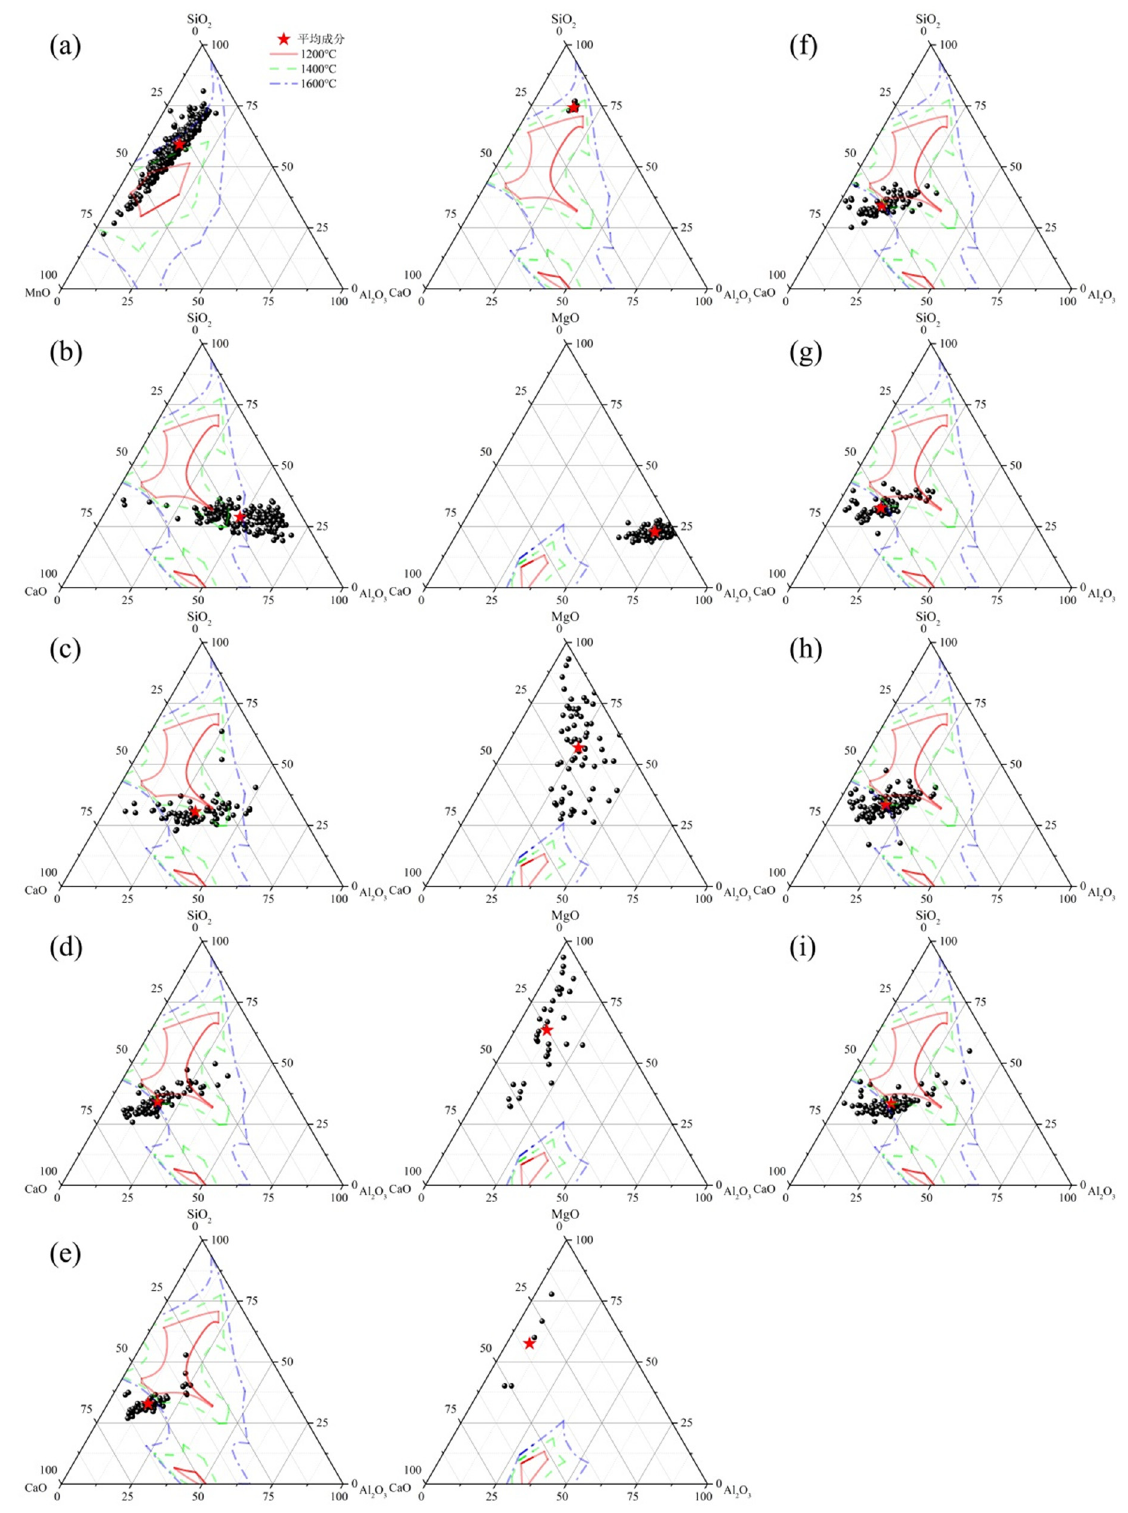
Figure 4: Composition distribution of inclusions at di ff erent stages during the LF – RH re fi ning process in heavy rail steel: ( a ) LF start; ( b ) after fi rst - time electrode heating; ( c ) after second - time electrode heating; ( d ) RH start; ( e ) RH vacuum holding for 5 min; ( f ) RH vacuum holding for 10 min; ( g ) RH vacuum holding for 15 min; ( h ) RH vacuum breaking; and ( i ) after RH soft